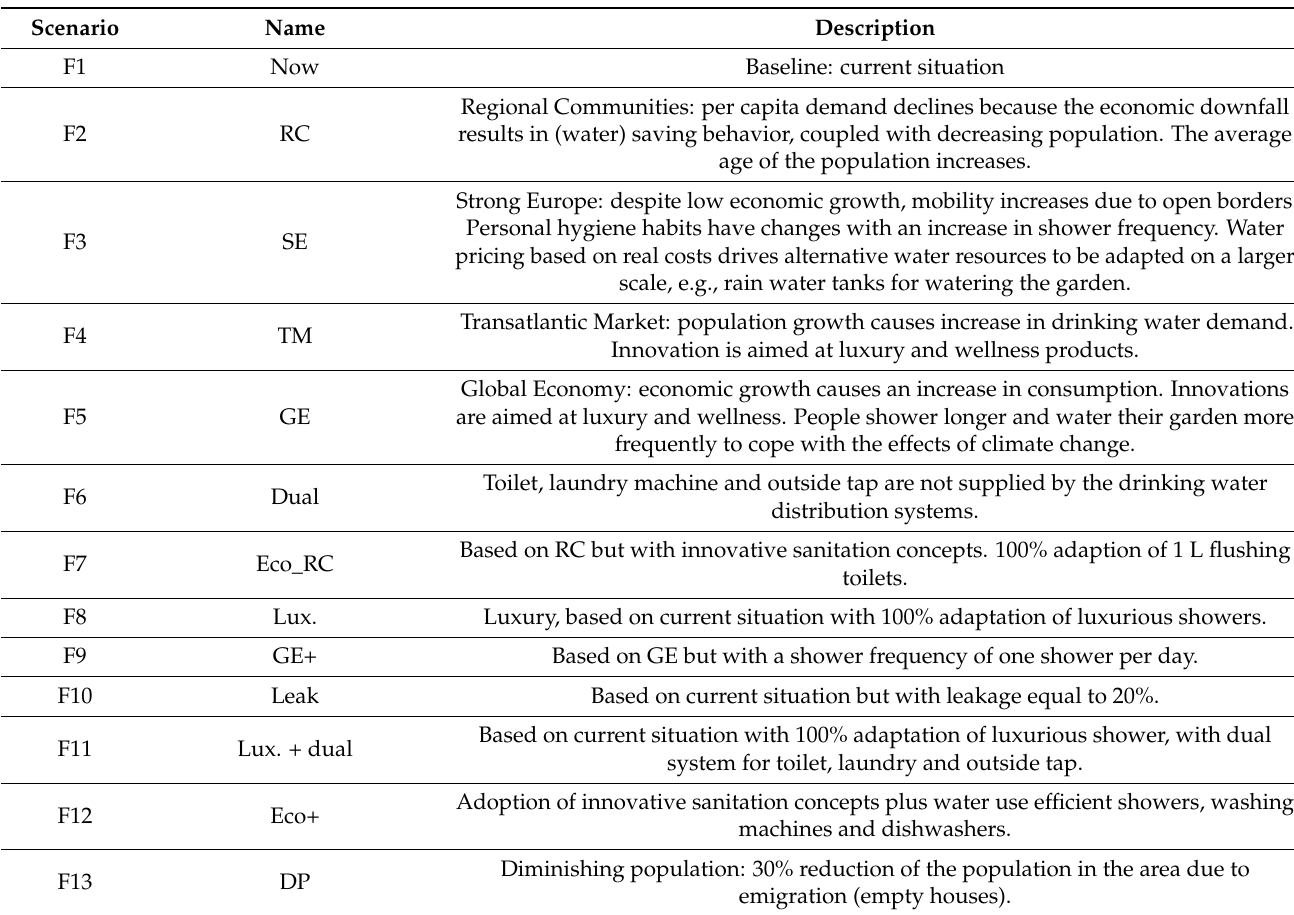
Table 2. Future water demand scenarios described in